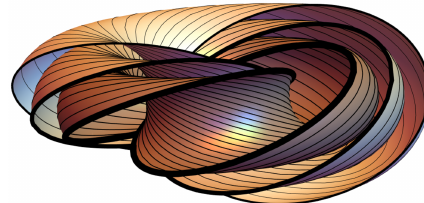
Figure 1: A portion of the Hopf fibration of S 3 (here visualized using stereographic projection to (cid:82) 3 ): each fiber is a circle S 1 labelled by a point in an S 2 base space [ 45 ] . The trajectories of edge modes in an isotropic 4D quantum Hall droplet coincide with such S 1 fibers in an S 3 boundary; they are localized on nested tori, each of which is itself partitioned into (chiral) Villarceau circles. By contrast, in generic anisotropic droplets, each torus is filled densely by a single edge mode